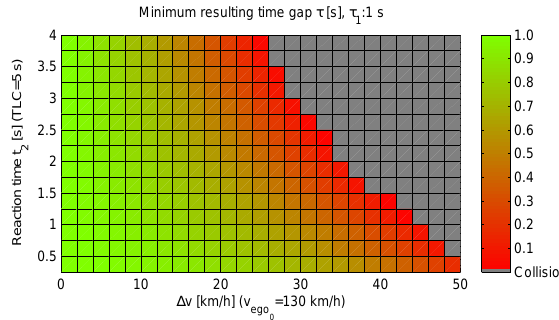
Figure 3: Simulation of the resulting minimum time gap τ [ s ] un- der given conditions. The gray areas hint towards unavoidable collisions.